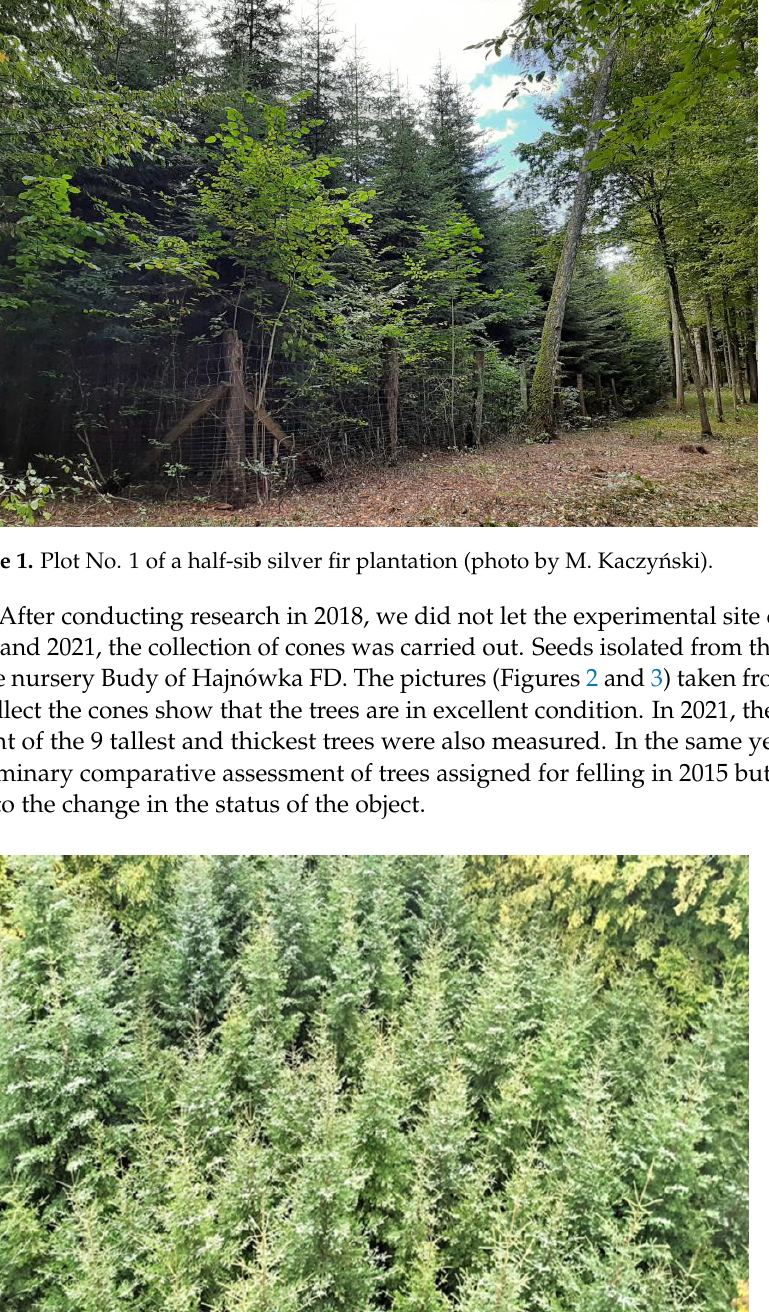
Figure 3. Fruiting of individual trees on plot No. 1 of the half-sib silver fir plantation in 2021 (photo by K. Wilamowski). The crowns are pointed (positive growth trend) with dense, bright green needles. One can notice a pronounced difference in heights, which corresponds to a difference in diameters. However, the crowns of trees of the lower growth classes also look good. The aerial view shows no apparent openings in the canopy. Furthermore, 38 trees formed cones in 2021, and some showed repeated (after 2020) fruiting. As a rule, these are trees with the largest diameter. However, fruiting was also recorded on small-diameter trees. All these facts indicate that the condition of the trees on the site for three years after the study continues to be very good and is in no way a cause for concern. 2.2. Collection of Field Data and Its Standard Processing Tree growth was assessed by analyzing the diameter at 1.3 m from the root collar or DBH, which represents it well and is easy to measure in dense stands (in contrast to height measurement). To determine the influence of the provenance factor for the ten half-sib families, we measured the diameters of all 701 trees to an accuracy of 0.1 cm. The representation of the families varied considerably: from 11 specimens in families 16 and